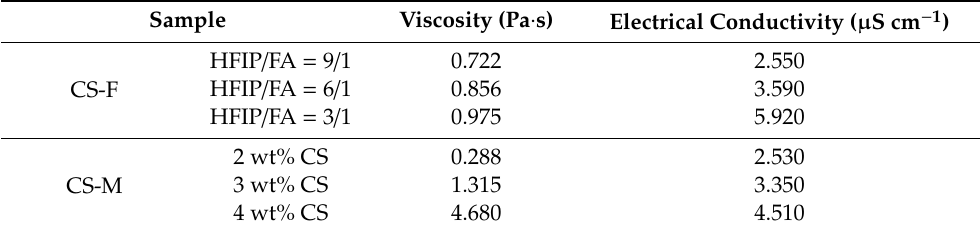
Table 1. Physical parameters of electrospinning / electrospraying solutions.